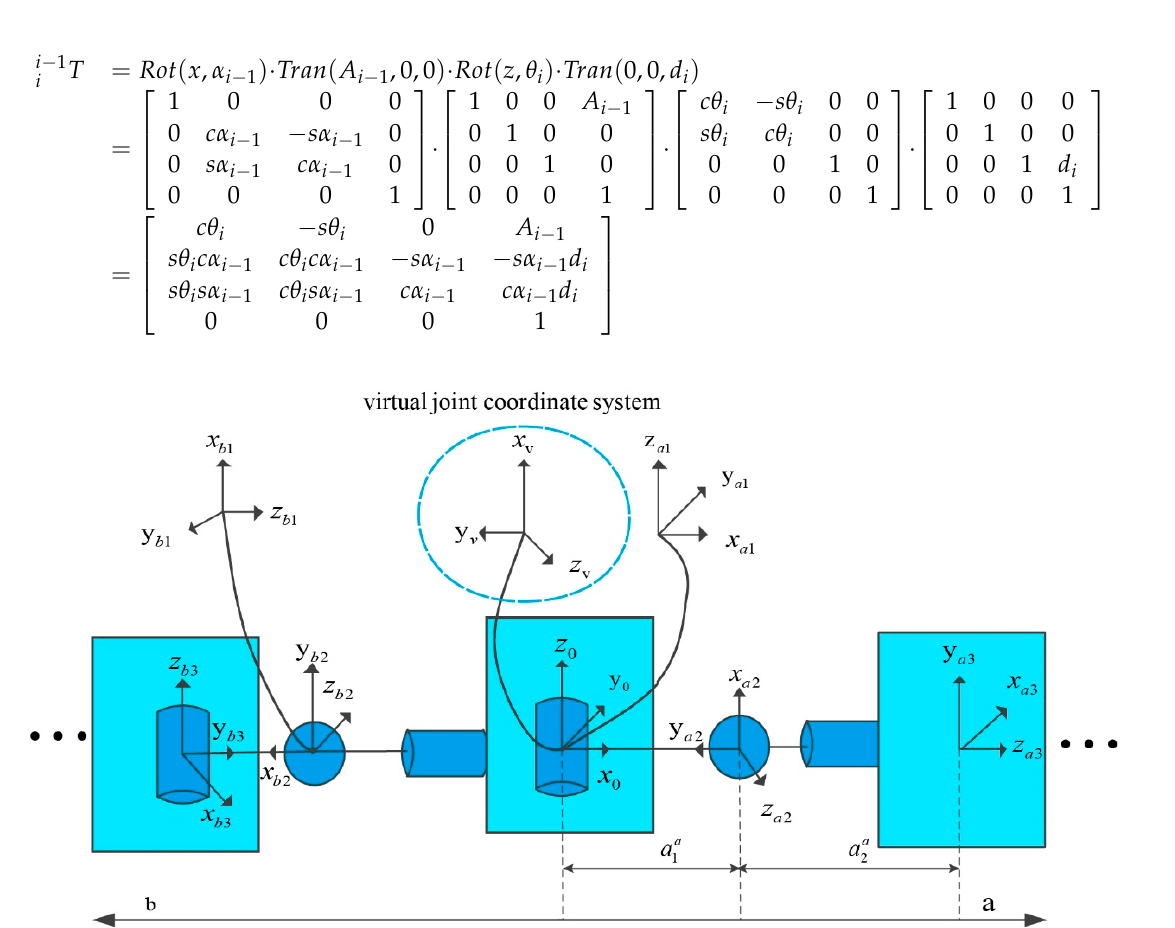
Figure 4. The link coordinate system of SMSRS.